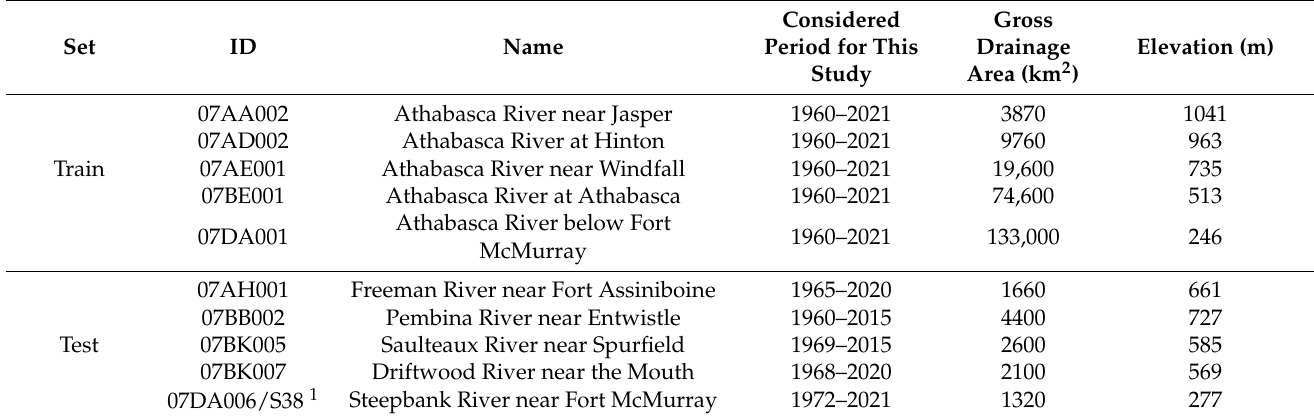
Table 1. Hydrometric stations used in this